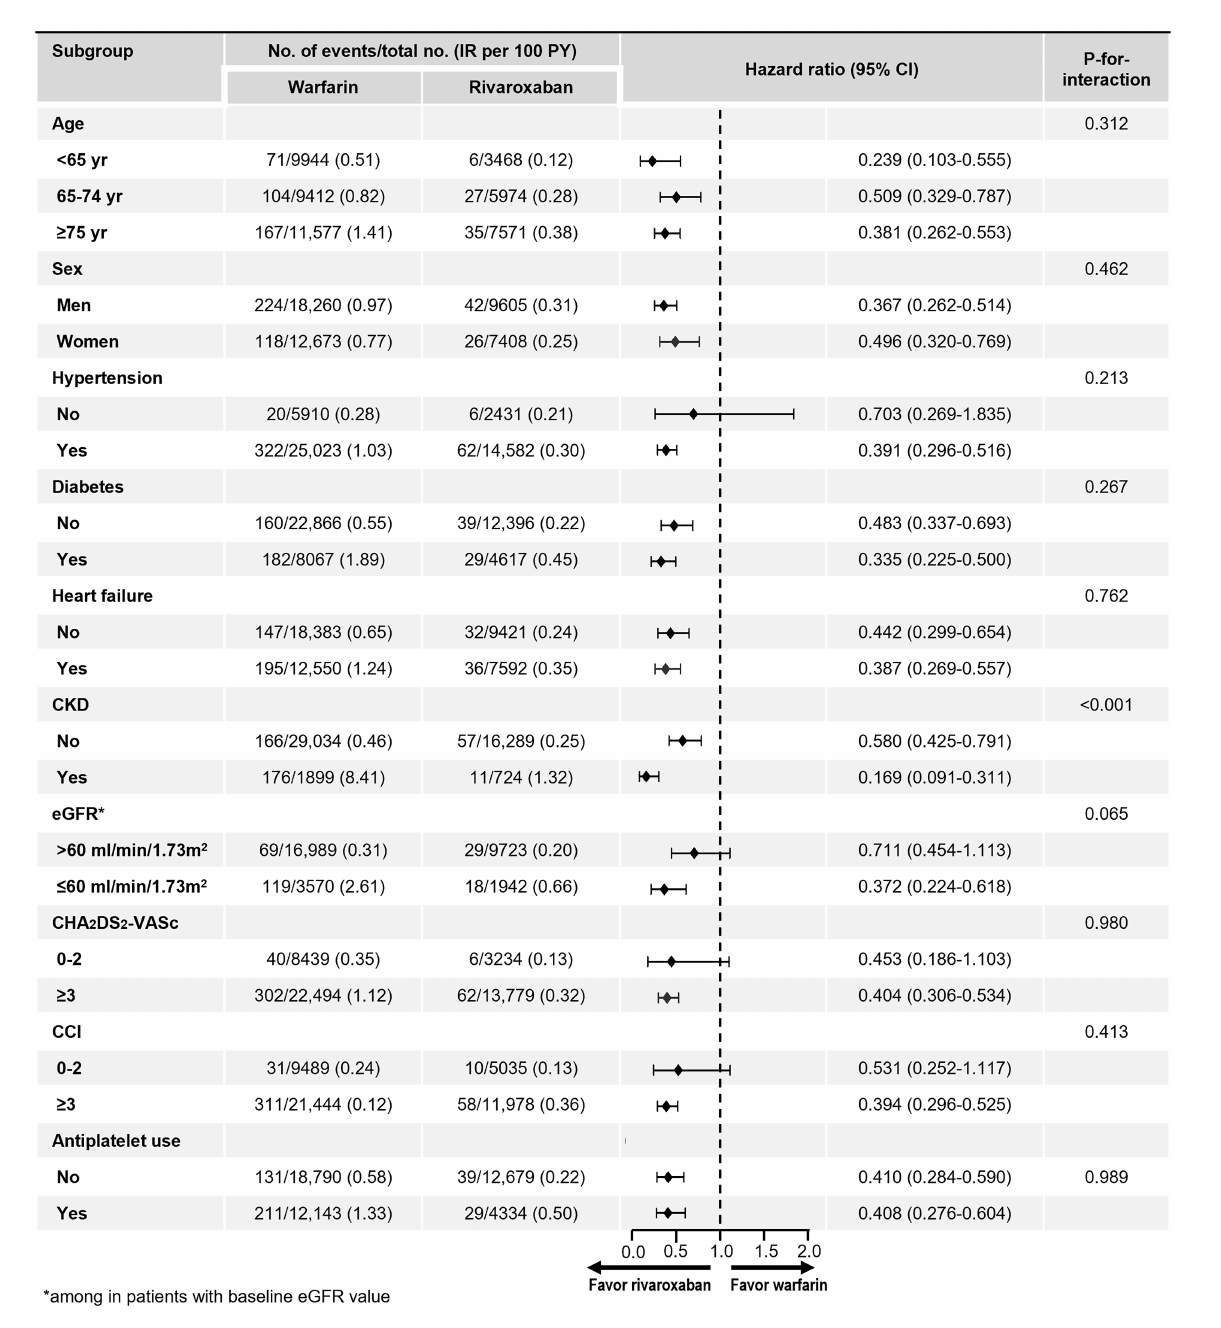
FIGURE 3 Subgroup analyses. CCI, Charlson comorbidity index; CI, confidence interval; CKD, chronic kidney disease; eGFR, estimated glomerular filtration rate; IR, incidence